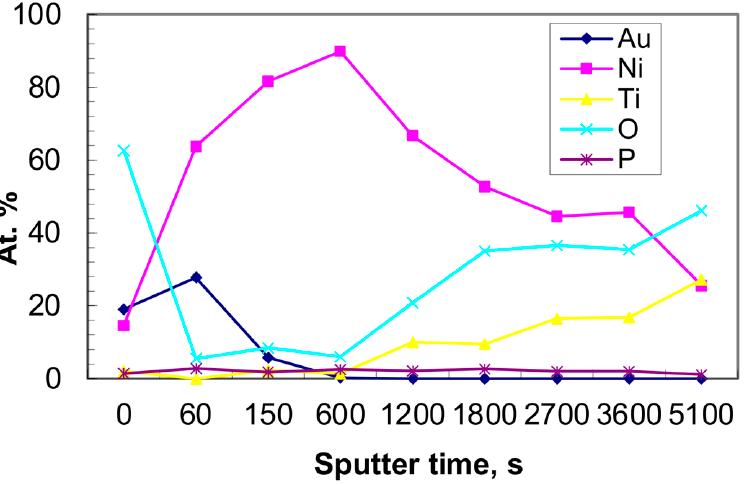
Figure 4. Auger sputter-etch depth profiles of elements at a AuNi layer on a TiO 2 ntb surface. The TiO 2 ntb electrode was immersed in the Ni plating bath at 85 °C for 20 s, followed by dipping of the prepared Ni-TiO 2 ntb electrode in an Au plating solution for 60 s.